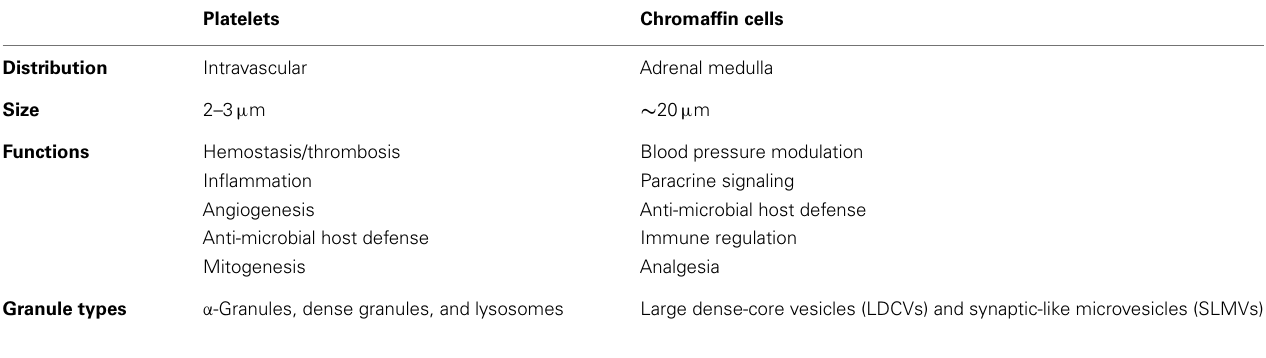
Table 1 | Comparison of platelets and chromaffin